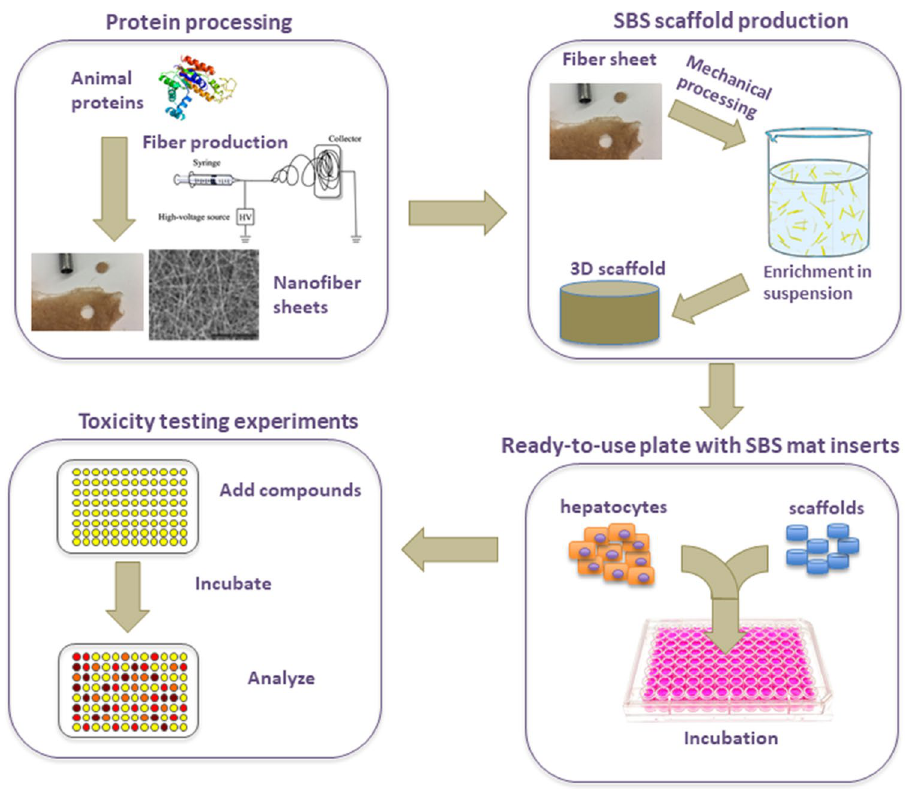
Figure 8. SBS mat technology summary. More details can be found in “Materials and methods”